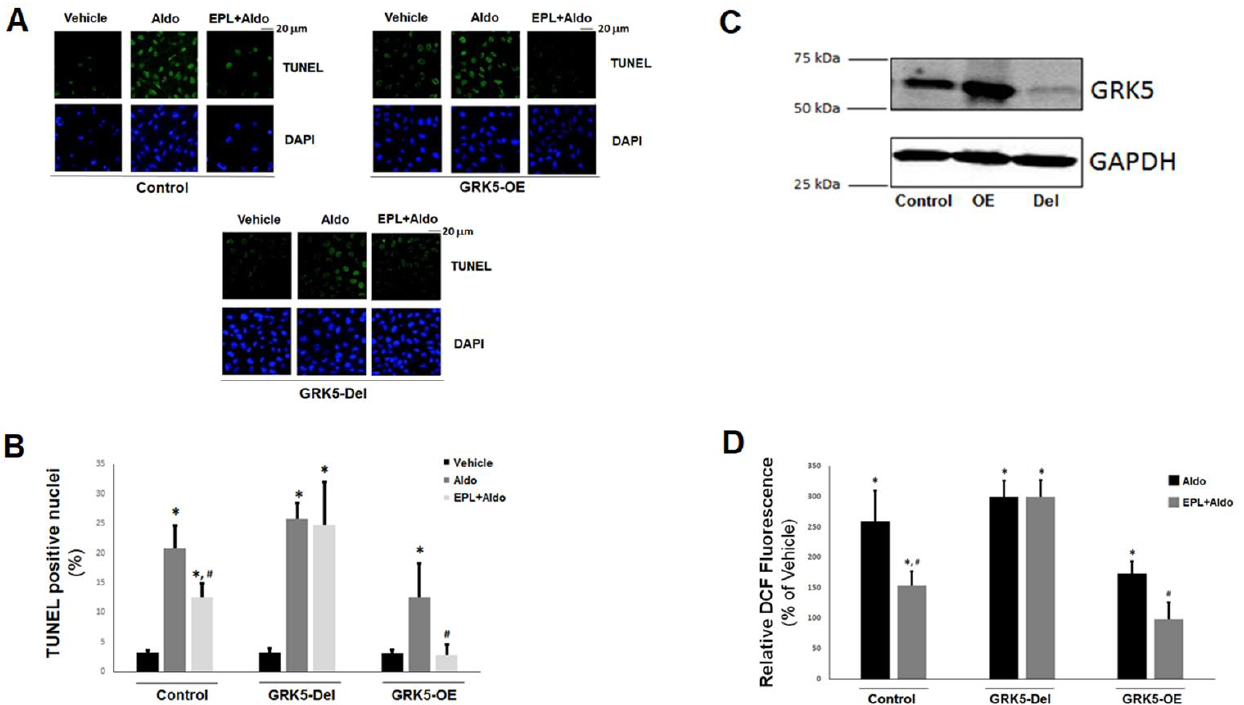
Figure 1. Effects of GRK5 in Aldo-induced apoptosis in adult rat ventricular myocytes (ARVMs): ( A , B ) Apoptotic cell death, measured by terminal deoxynucleotidyl transferase dUTP nick-end labeling (TUNEL), in cultured ARVMs having GRK5 genetically (via CRISPR) deleted (GRK5-Del) or overexpressing GRK5 (GRK5-OE) and treated with 100 nM Aldo or 100 nM Aldo in the presence of 10 µM eplerenone (EPL + Aldo) for 24 h. Representative images of TUNEL-positive nuclei identified by 4′,6-diamidino-2-phenylindole (DAPI) counterstaining are shown in ( A ), and the quantitation of the TUNEL imaging results are shown in ( B ). Control: CRISPR-negative control virus (CNCV)-infected cells. * p < 0.05, vs. vehicle; # , p < 0.05, vs. Aldo; n = 5 independent experiments per transfection/treatment. ( C ) Immunoblotting for GRK5 in extracts from cultured ARVMs, transfected with control empty vector/mock lentivirus (Control), full-length wild-type GRK5-encoding lentivirus to overexpress GRK5 (OE), or CRISPR rat GRK5-specific lentivirus to delete the gene for GRK5 (Del). Total protein extracts were prepared 48 h post-infection and then separated on a 4–20% SDS-PAGE gel. A repre- sentative blot is shown, including GAPDH as loading control, of five independent experiments performed in duplicate, confirming GRK5 overexpression and deletion in OE and Del ARVMs, respectively. ( D ) Reactive oxygen species (ROS) generation, as measured with a 2′,7′-dichlorofluorescein diacetate (DCFDA)-based assay kit, in cultured ARVMs having GRK5 genetically (CRISPR-mediated) deleted (GRK5-Del) or overexpressing GRK5 (GRK5-OE) and treated with 100 nM aldosterone (Aldo) or 100 nM aldosterone in the presence of 10 µM eplerenone (EPL + Aldo) for 24 h. Results are expressed as % of the fluorescence measured upon vehicle (DMSO) treatment for each cell clone. Control: Empty vector/mock lenti- virus-infected ARVMs. Eplerenone alone had no effect. * p < 0.05, vs. vehicle; # p < 0.05, vs. Aldo; n = 6 independent exper- iments per transfection/treatment.